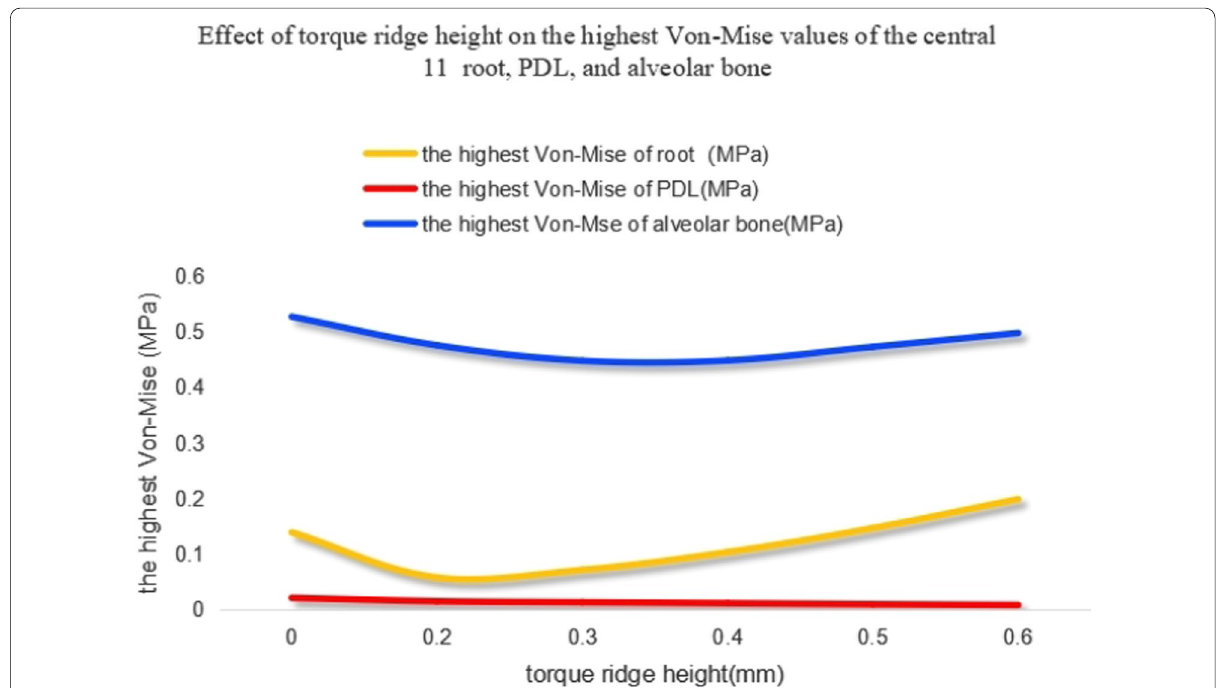
Fig. 8 The highest von-Mises value of the central incisor root, PDL, and alveolar bone with different power ridge heights when U1-SN